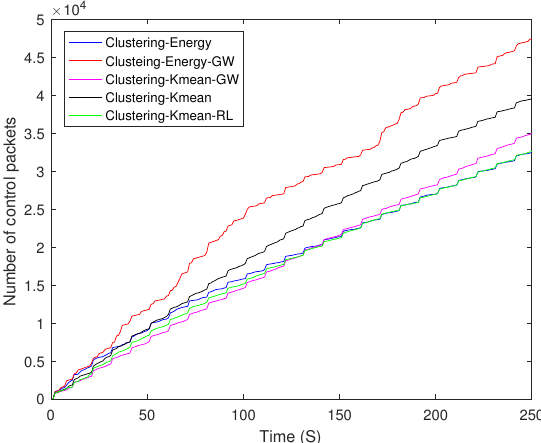
Figure 14. Control packets sent by different clustering schemes.